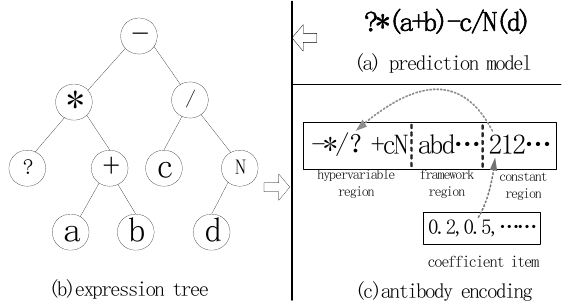
Fig. 4. Mapping relationship of prediction model, expression tree and antibody